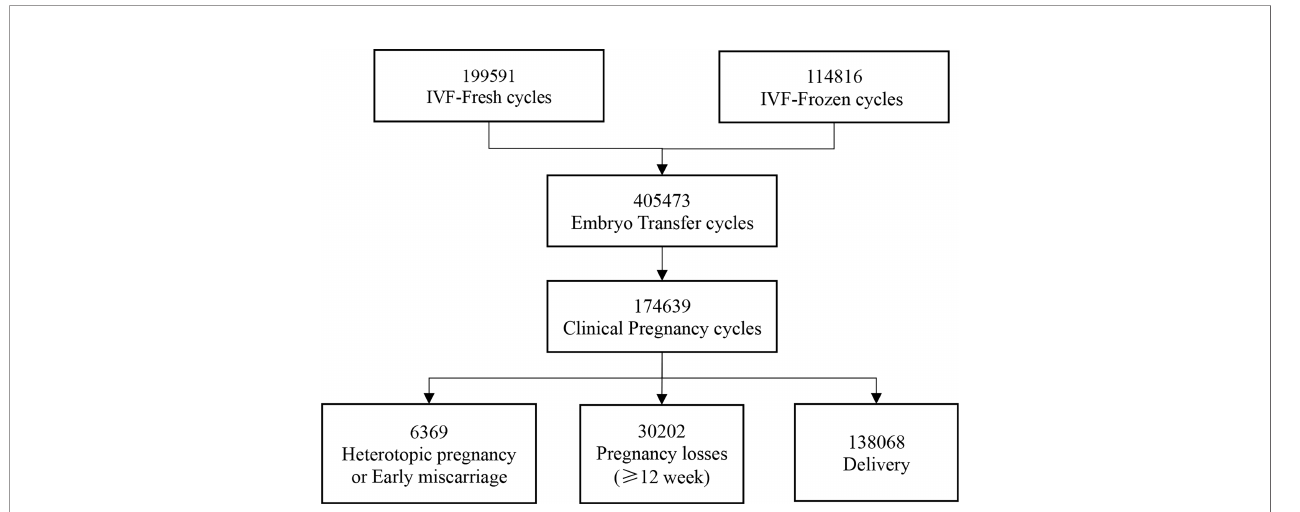
FIGURE 1 | Flowchart showing patient